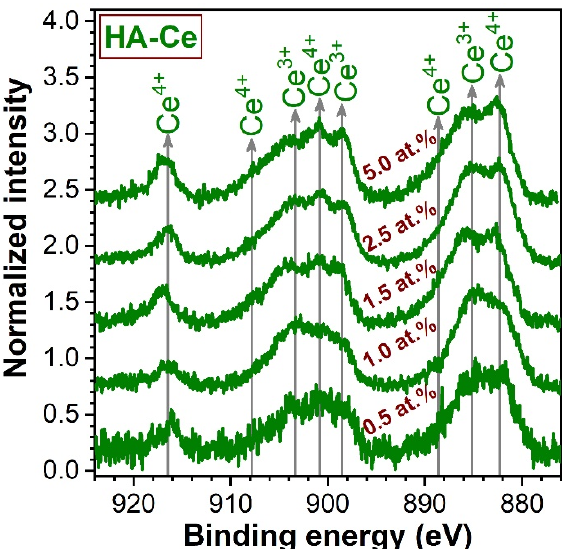
Figure 2. X-ray photoelectron spectra collected in the Ce 3d core electron level region in the case of HA-Ce NPs.